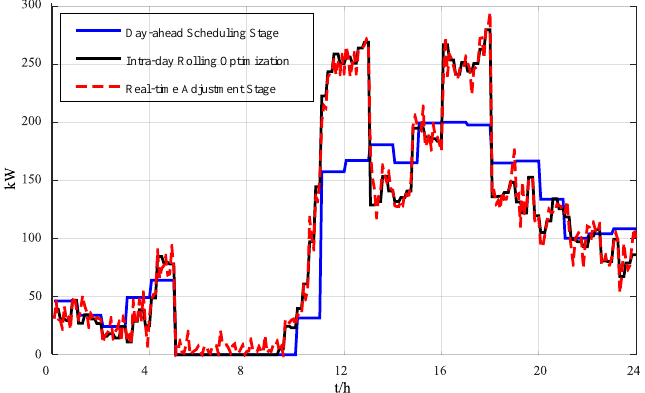
Figure 9. Refrigeration power of the electric refrigerator at multiple time scales.